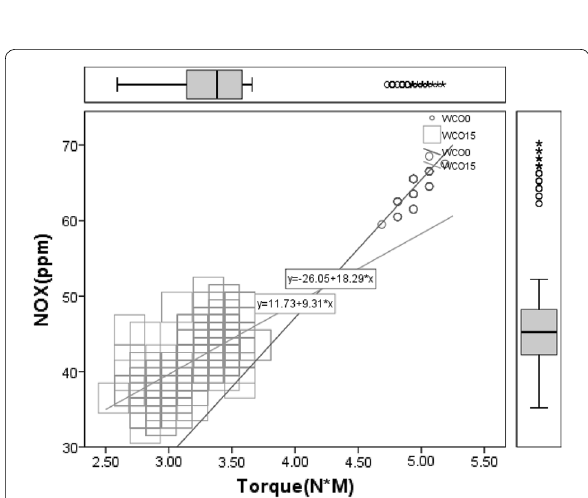
Fig. 15 Scatter plot diagrams for the exhaust characteristics versus torque output [NO x emission (Unit: